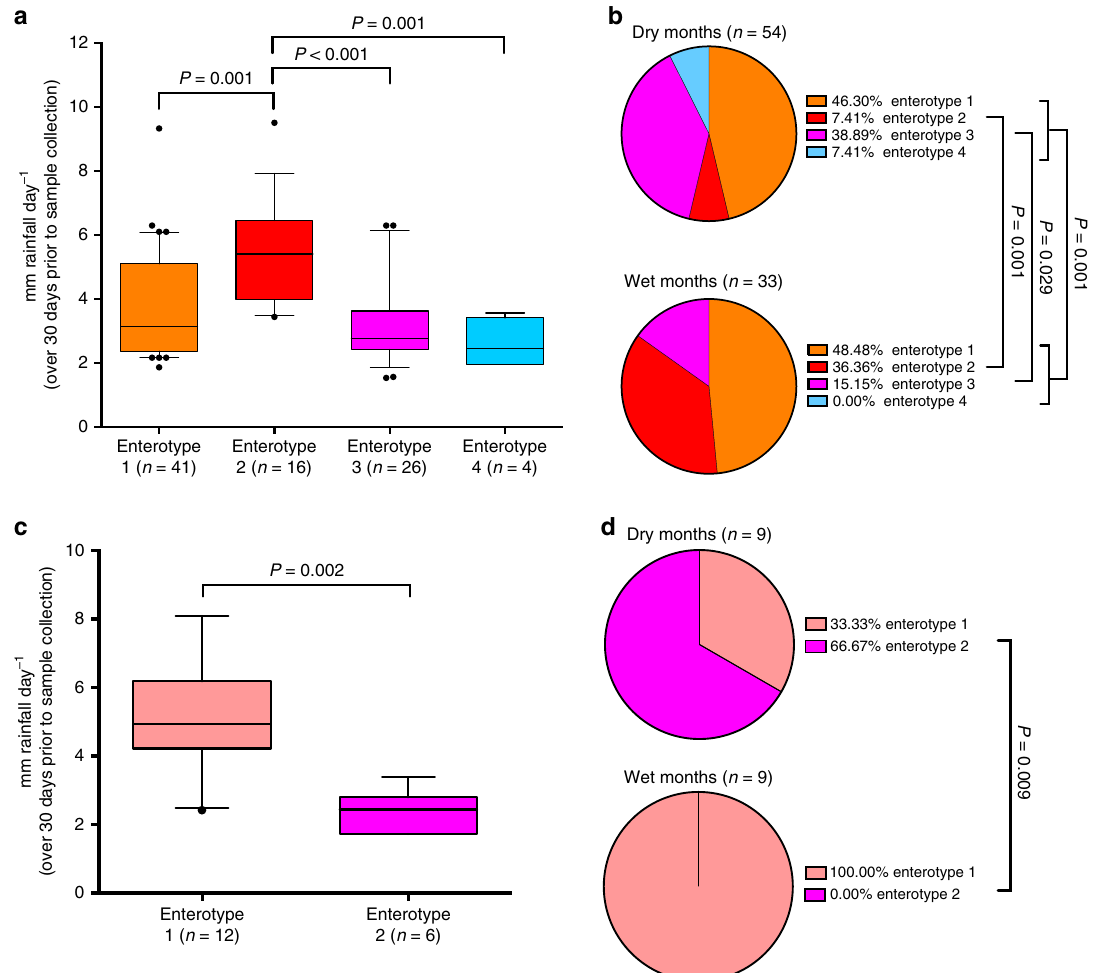
Fig. 5 The fecal microbiota compositions and enterotype distribution of WLGs and sympatric chimpanzees vary with seasonal patterns of rainfall. a Box- and-whiskers plots showing the distribution of average rainfall per day over the 30 days prior to sample collection for each WLG enterotype. b Pie charts showing the proportion of samples from each WLG enterotype in wet (>4.23 mm day − 1 ) and dry months (<4.23 mm day − 1 ). c Box-and-whiskers plots showing the distribution of average rainfall per day over the 30 days prior to sample collection for each chimpanzee enterotype. d Pie charts showing the proportion of samples from each chimpanzee enterotype in wet (>4.23 mm day − 1 ) and dry months (<4.23 mm day − 1 ). Two-tailed P- values from Mann – Whitney tests are indicated in a and c . Two-tailed P -values from a χ 2 -test (all WLG enterotypes in dry months vs. wet months) and Fisher ’ s exact tests (WLG enterotype 2 in dry months vs. wet months, WLG enterotype 3 in dry months vs. wet months, chimpanzee enterotypes 1 and 2 in dry months vs. wet months) are indicated in b ,